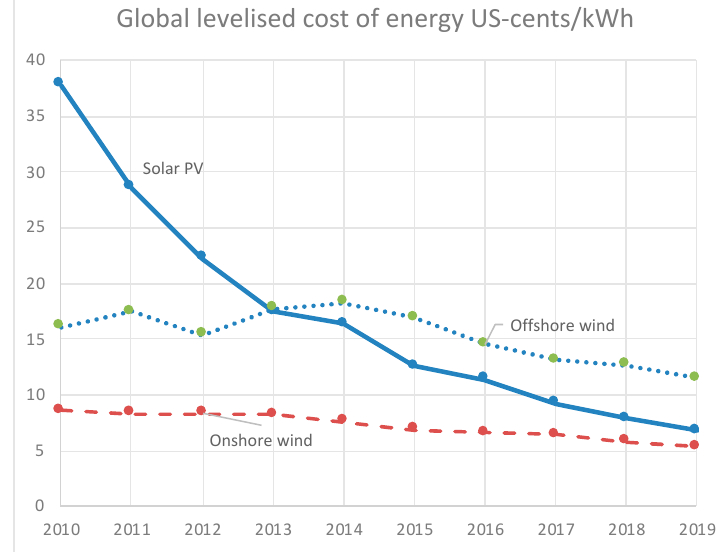
Figure 4. Global levelised cost of different renewable energy (RE) technologies 2010–2019 9 .